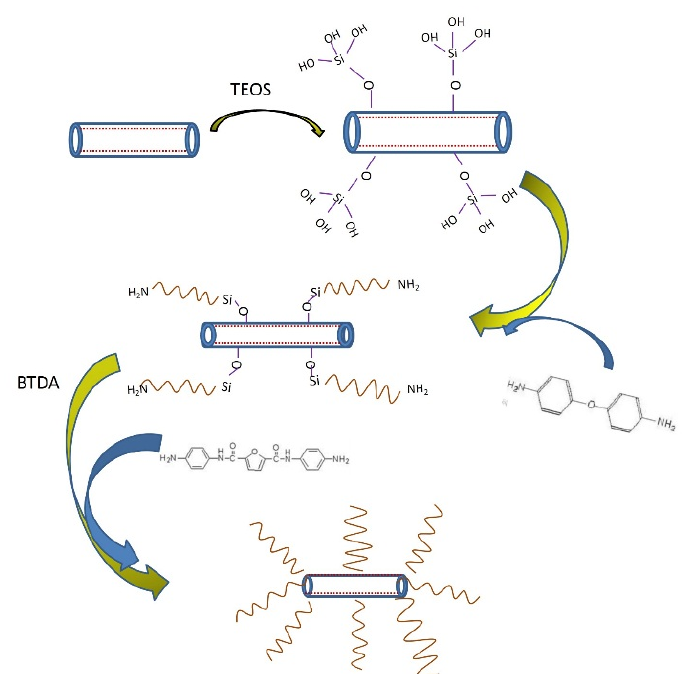
Figure 1. The preparation scheme to prepare bio-based polyimide/HNTs nanocomposite.